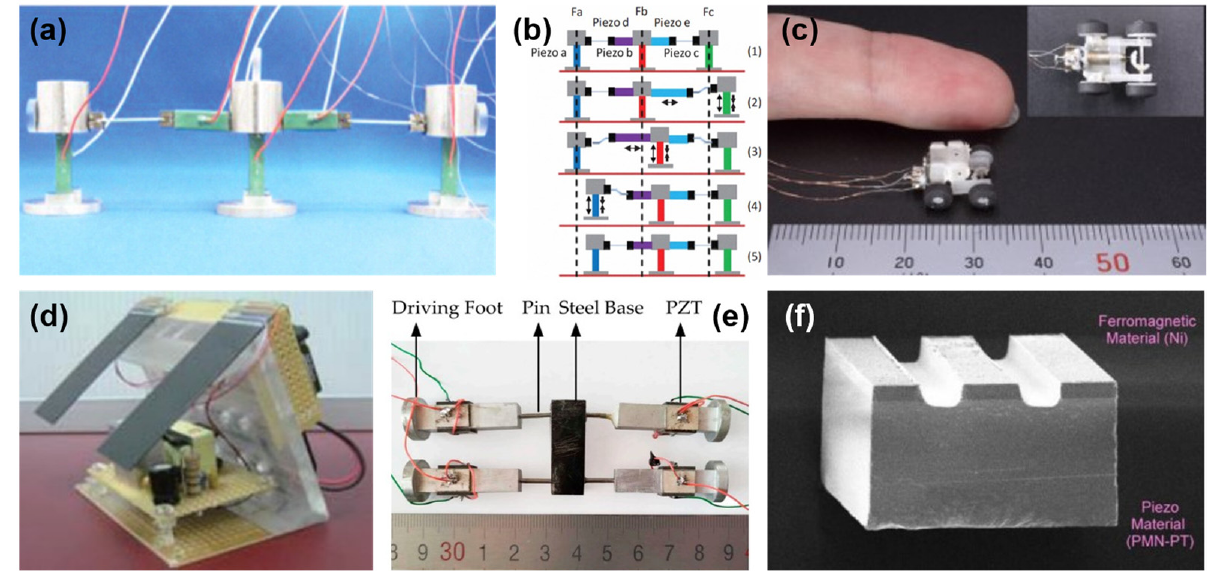
Figure 3. ( a ) Photograph and ( b ) principle of the inchworm microrobot. Reprinted with permission from Ref. [15]. Copyright 2011, IEEE . ( c ) Rolling microrobot. Reprinted with permission from Ref.